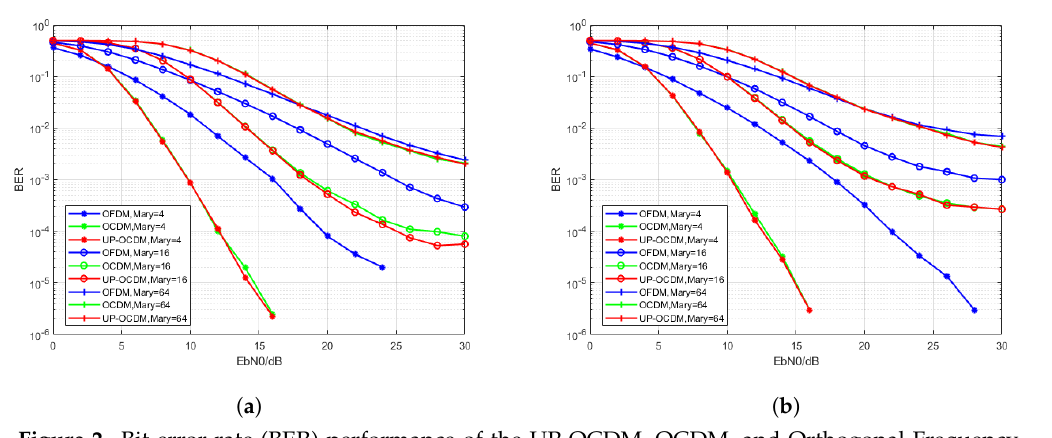
Figure 2. Bit error rate (BER) performance of the UP-OCDM, OCDM, and Orthogonal Frequency Division Multiplexing (OFDM) systems with minimum mean square error (MMSE) equalizers under the 16-ray doubly selective channels with the normalized Doppler spread of 0.1 ( a ) and 0.3 ( b